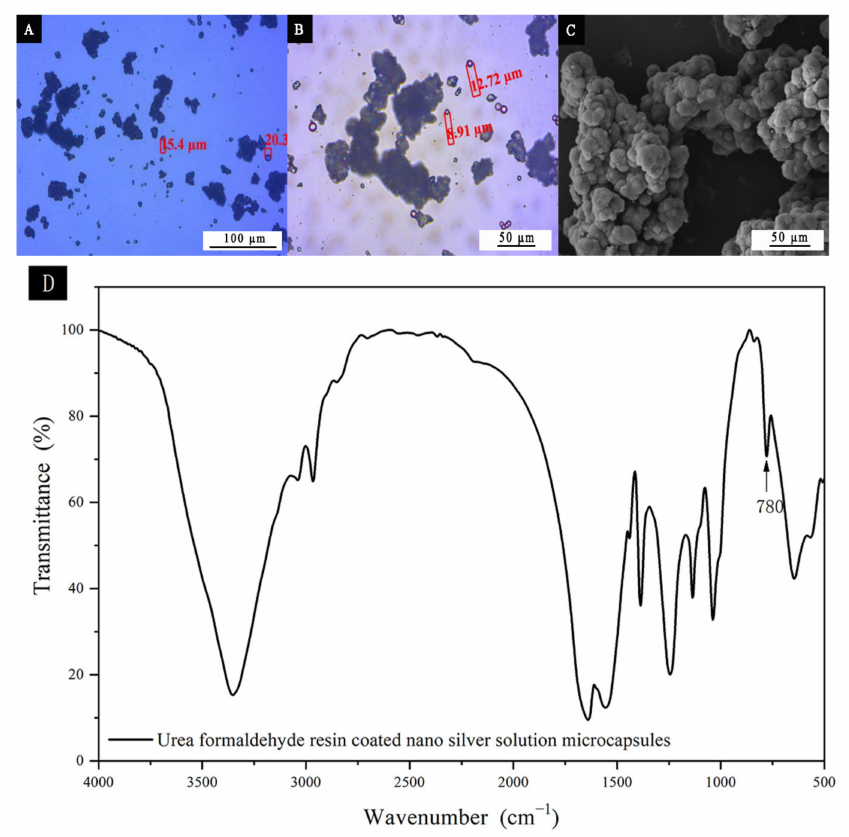
Figure 2. OM of urea formaldehyde resin-coated nano-silver solution microcapsules: ( A ) under 10 × objective lens and ( B ) under 20 × objective lens. ( C ) SEM microscopic view of urea formaldehyde resin-coated nano-silver solution microcapsules and ( D ) infrared spectrum of urea-formaldehyde resin-coated nano-silver solution